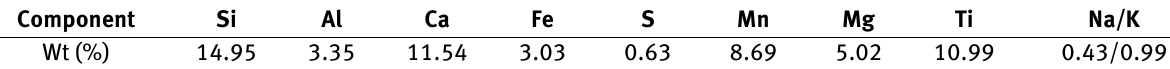
Table 1: Energy spectrum analysis of chemical composition of inclusion shown in Figure 2.